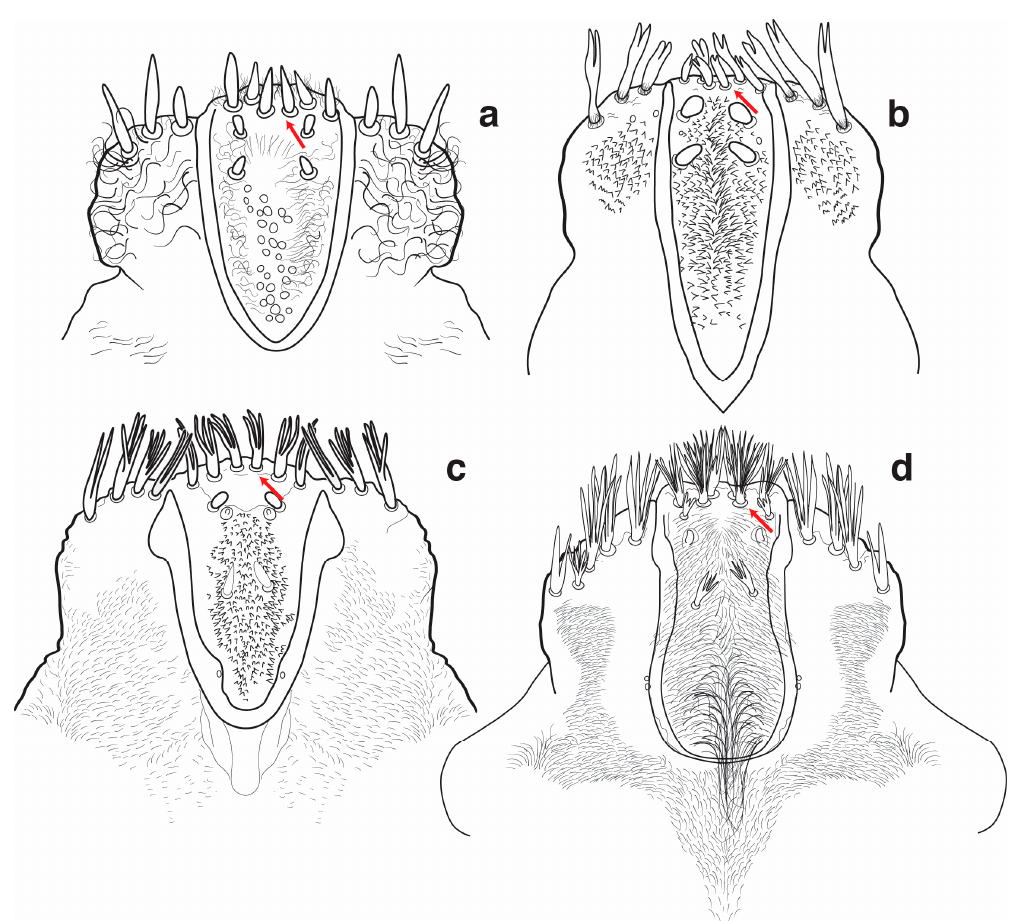
Figure 33. Epipharynx, larva: ( a ) Nephius (=Anius) ; ( b ) Eugnoristus ; ( c ) Sipalinus ; and ( d ) Yuccaborus .